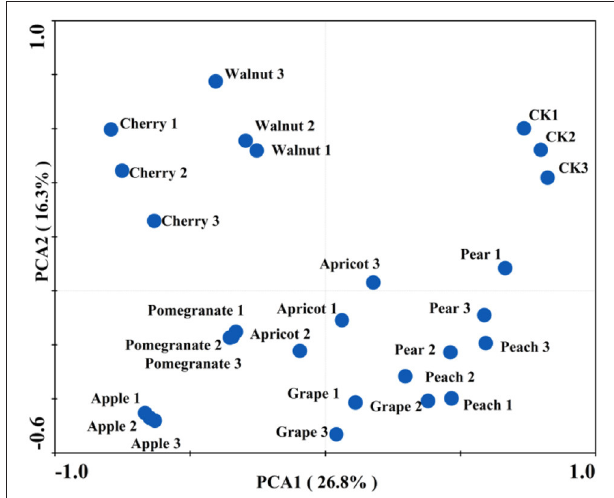
Frontiers in Microbiology |